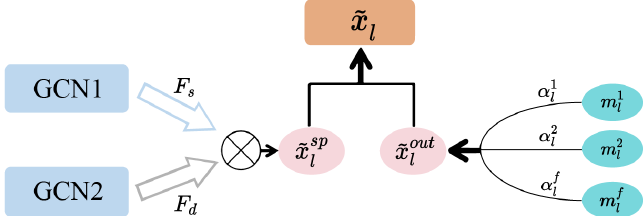
Figure 7. Fusion of internal network and external